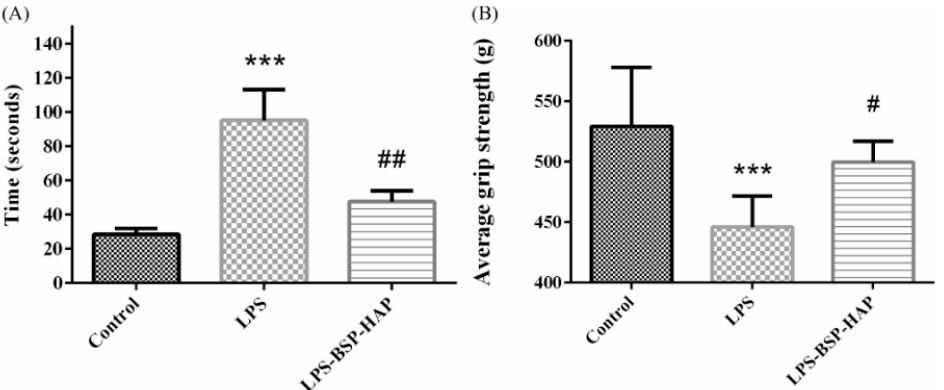
Figure 8. Muscle endurance analysis by using treadmill test ( A ). Average grip strength was measured by using a grip strength meter ( B ). ( n = 6, *** p < 0.001 compared with control group; # p < 0.05 compared with LPS group; ## p < 0.01 compared with LPS group). From these results, we infer that the muscle endurance and grip strength of rats with LPS-induced sarcopenia and treated with BSP-HAP for 2 months may fully recover.